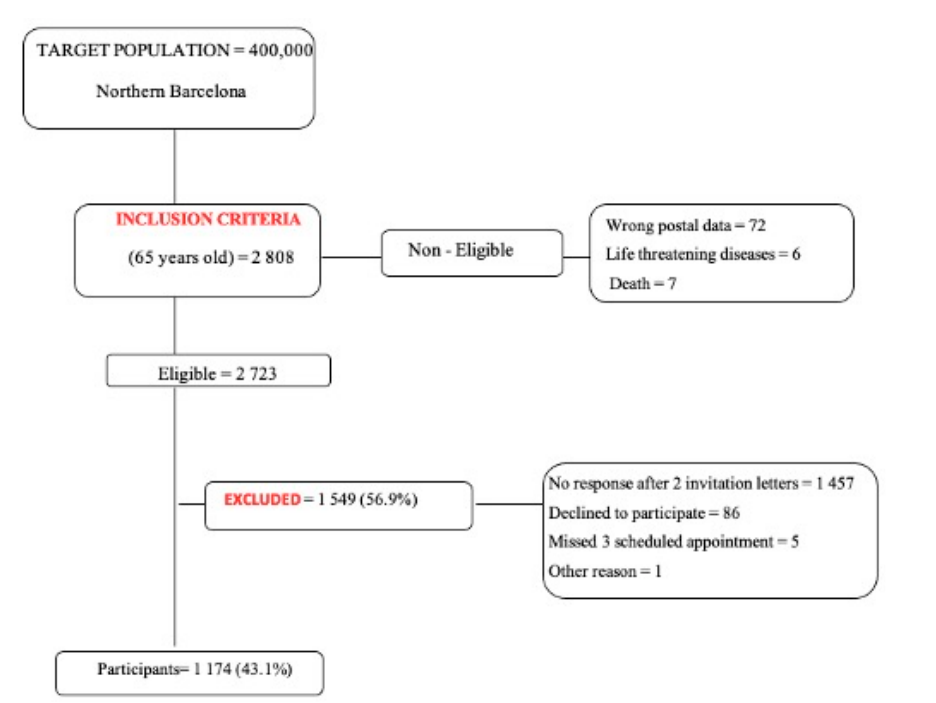
Figure 1. Flowchart of initial inclusion description.